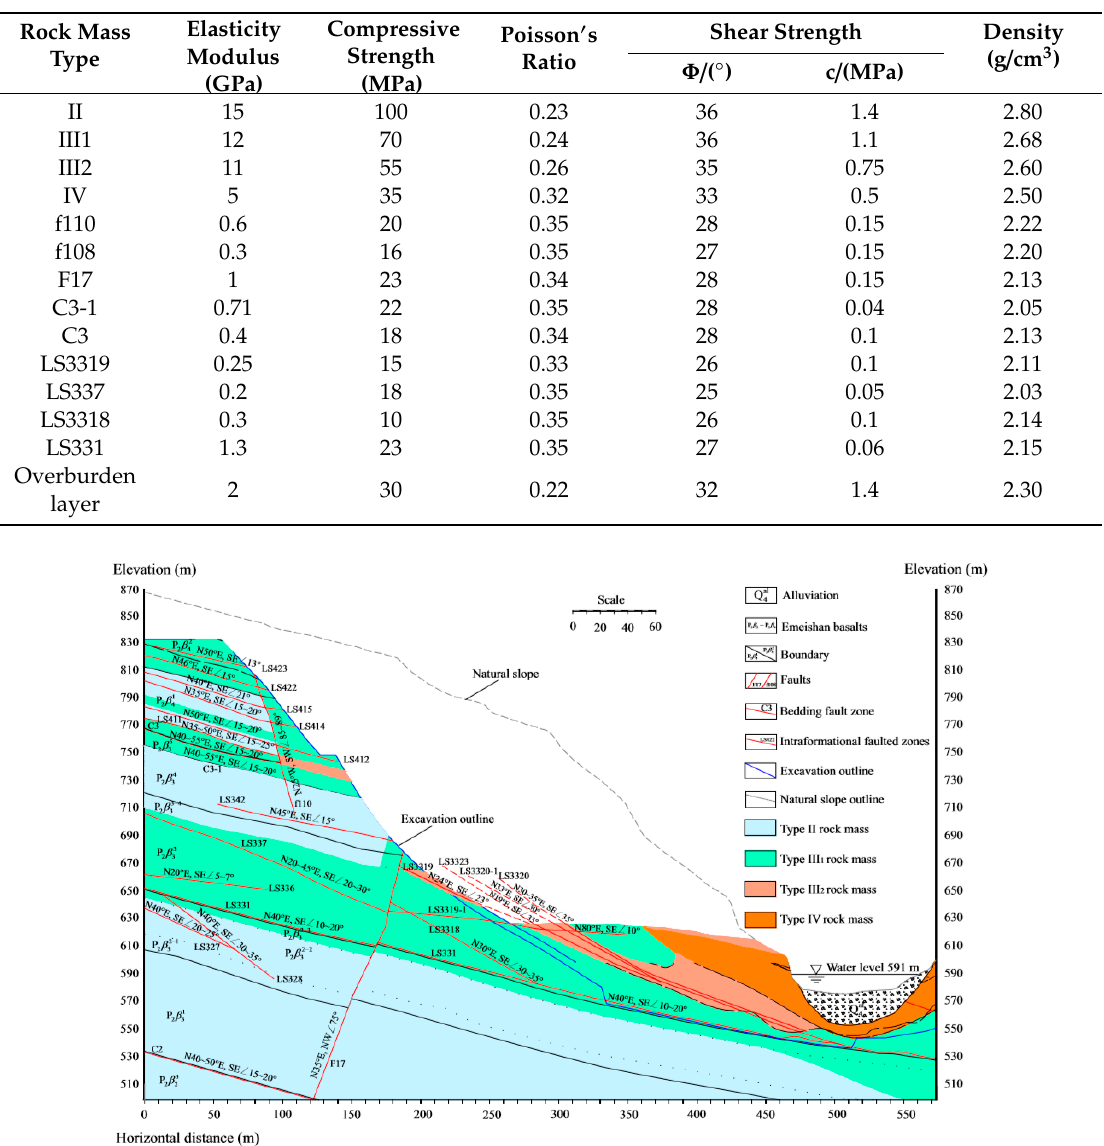
Table 4. Mechanical parameters in the numerical calculation [25].